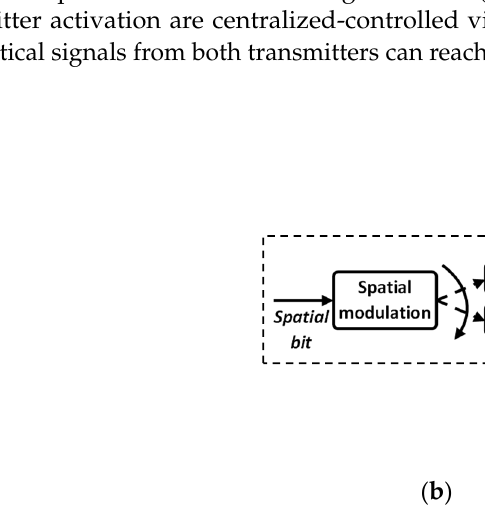
Figure 1. 2 × 1 MISO OWC system configuration and SM implementation. ( a ) 2 × 1 MISO OWC system; ( b ) principle of SM.